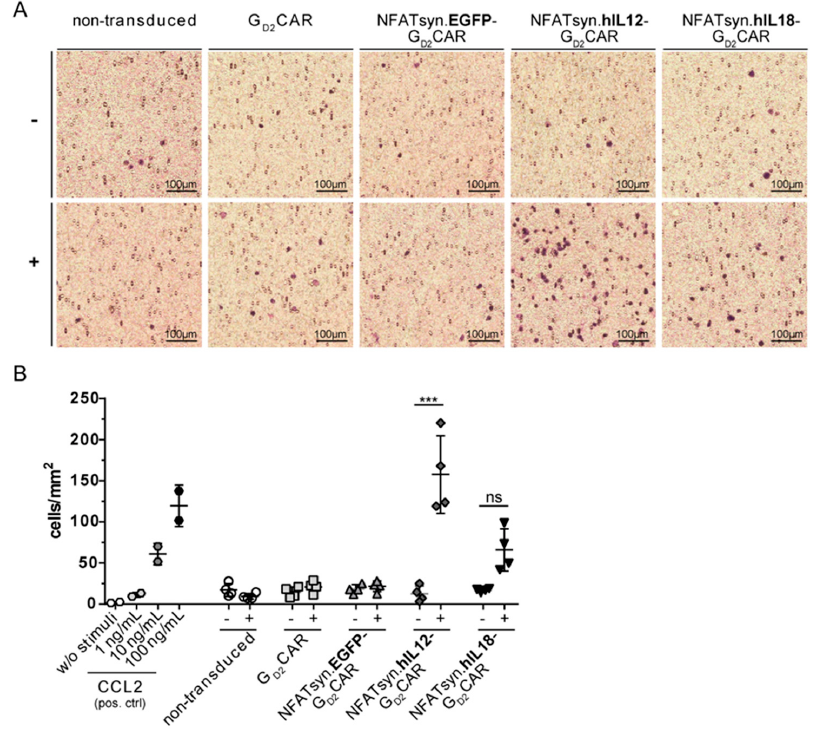
Figure 7. “All-in-one” NFATsyn.IL12-G D2 CAR and NFATsyn.IL18-G D2 CAR vector constructs exhibit higher recruitment potential of monocyte cell line MONO-MAC-6 (MM6) shown in a cell migration assay. Cell culture supernatants from co-culture experiments performed with “all-in-one” vector/G D2 CAR constructs transduced primary T cells (sorted) and GD2 + target cells (E/T 6:1) were collected after 48 h and used in a cell migration assay with modified Boyden chambers and 5 × 10 5 MM6 cells/well. Supernatants from cells w/o stimulation served as controls. (A) Membranes were fixed and Giemsa stained after 4 h incubation. ( B ) Graph summarizes four independent experiments (each performed in duplicates) of migrated cells influenced by the different cell culture supernatants of the “all-in-one” constructs harvested after co-culture with (+) or without ( − ) HT1080 GD2 + target cells. Different concentrations of C-C motifchemokine ligand 2 (CCL2) were used as positive control. Shown are mean values ± SEM. Indicated significance was determined by one-way ANOVA with Tukey´s multiple comparison test; *** p ≤ 0.001; ns > 0.05.